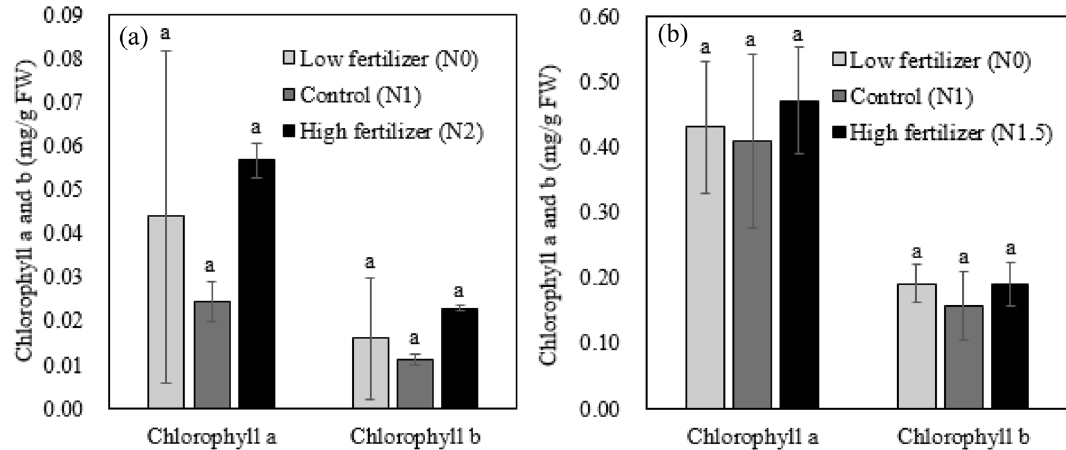
Figure 2. Chlorophyll content of pepper leaves treated with different urea fertilizer applications; greenhouse experiments ( a ) and field experiments ( b ).